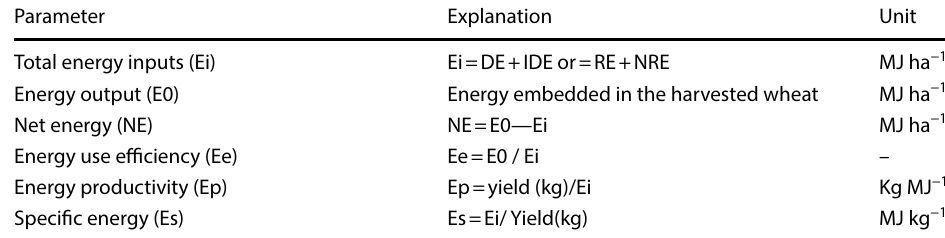
Table 2 Explanation of energy parameters